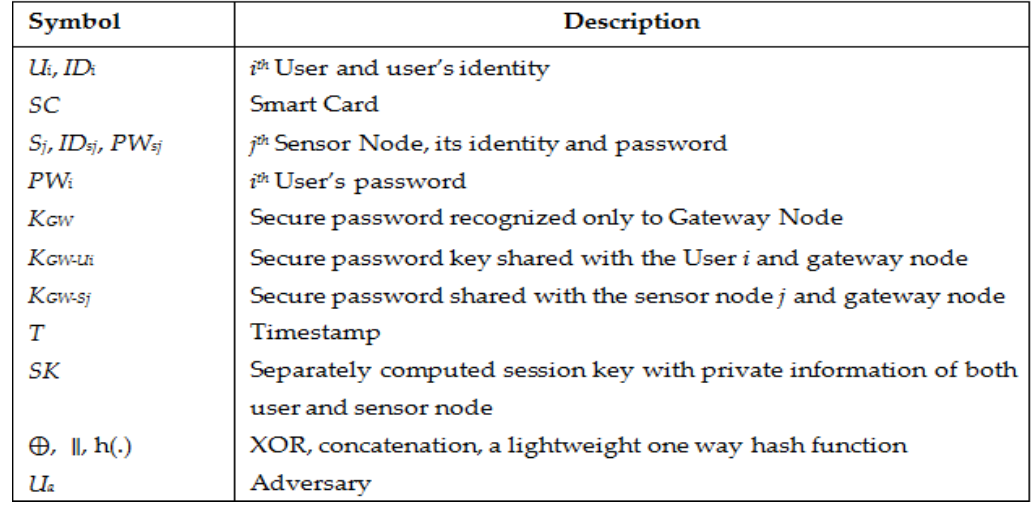
Figure 1. Notations and description.